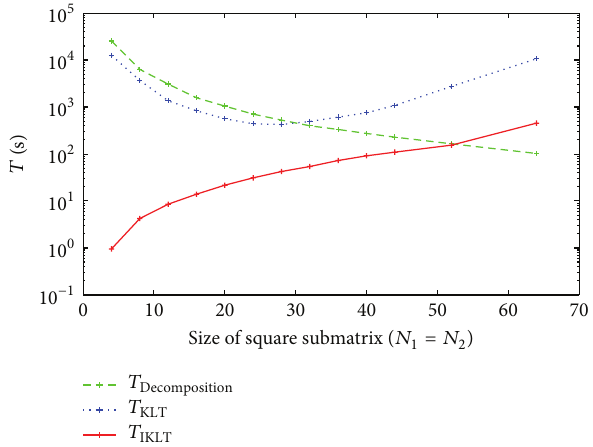
Figure 4: Numerical complexity of the KLT, inverse KLT, and submatrices